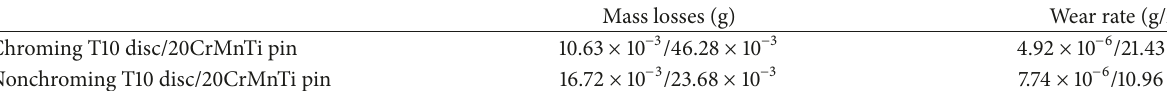
Table 1: Wear loss and wear rate of chroming/nonchroming T10 discs against 20CrMnTi pin.